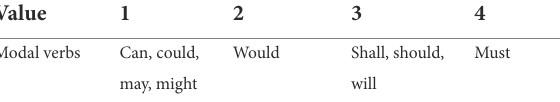
TABLE 1 Value classification of English modal verbs. TABLE 2 Chinese modal verbs